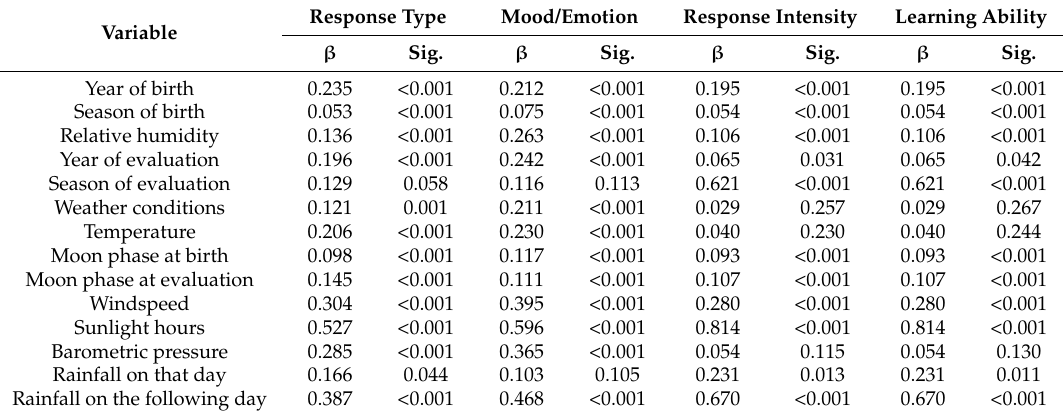
Table 5. Standardized coefficients and significance of categorical regression (CATREG)